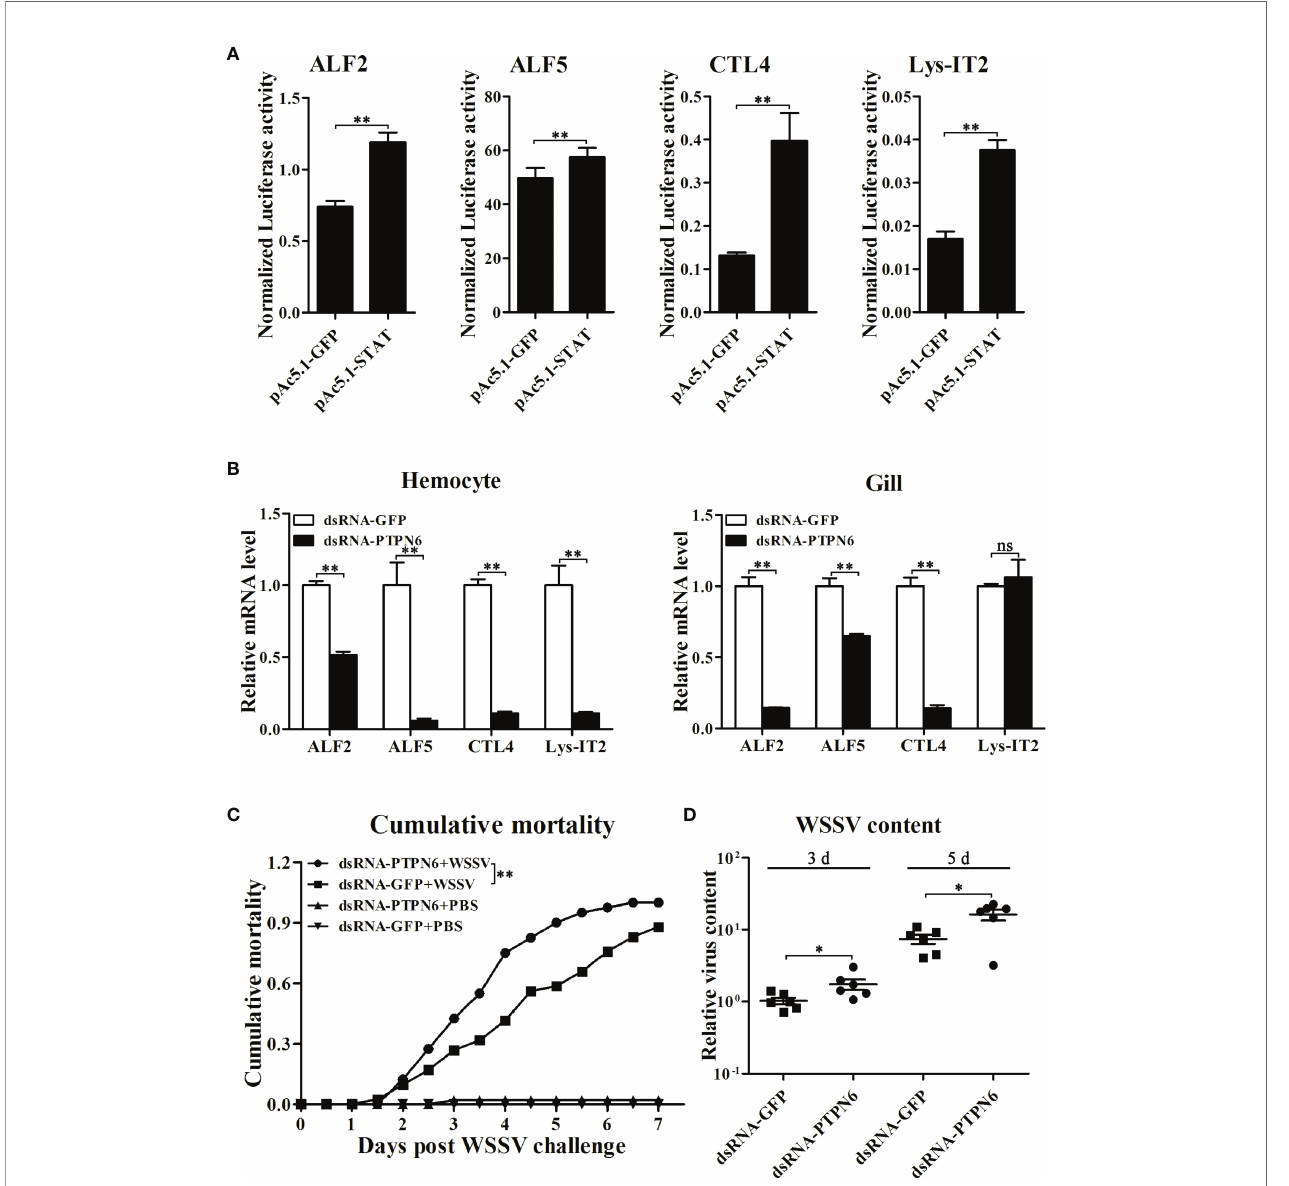
FIGURE 8 | Role of LvPTPN6 in shrimp antiviral immunity. (A) Regulatory effects of shrimp STAT on the promoter of immune effector genes. Each bar represents the mean ± SD ( n = 8), ** p < 0.01 by two-tailed unpaired Student ’ s t -test. (B) qRT-PCR analysis of the mRNA level of STAT-regulated immune effector genes in hemocyte and gill at 48 h after dsRNA injection. Values in the dsRNA-GFP control group were set as the baseline (1.0). Each bar represents the mean ± SD ( n = 4), ** p < 0.01 and ns : P > 0.05 by two-tailed unpaired Student ’ s t -test. (C) Cumulative mortality of dsRNA-injected shrimps ( n = 40) after WSSV infection. Data were recorded every 6 h and statistically analyzed by Kaplan – Meier log-rank c 2 test, ** p < 0.01. (D) The relative viral load in muscle was analyzed by detecting the DNA of the WSSV ie1 gene in six randomly selected shrimps using qRT-PCR with three repetitions, and the shrimp EF-1 a gene was used as the internal control. The level in dsRNA-GFP group at 3 days post WSSV infection was set as baseline (1.0). * p < 0.05 by two-tailed unpaired Student ’ s t